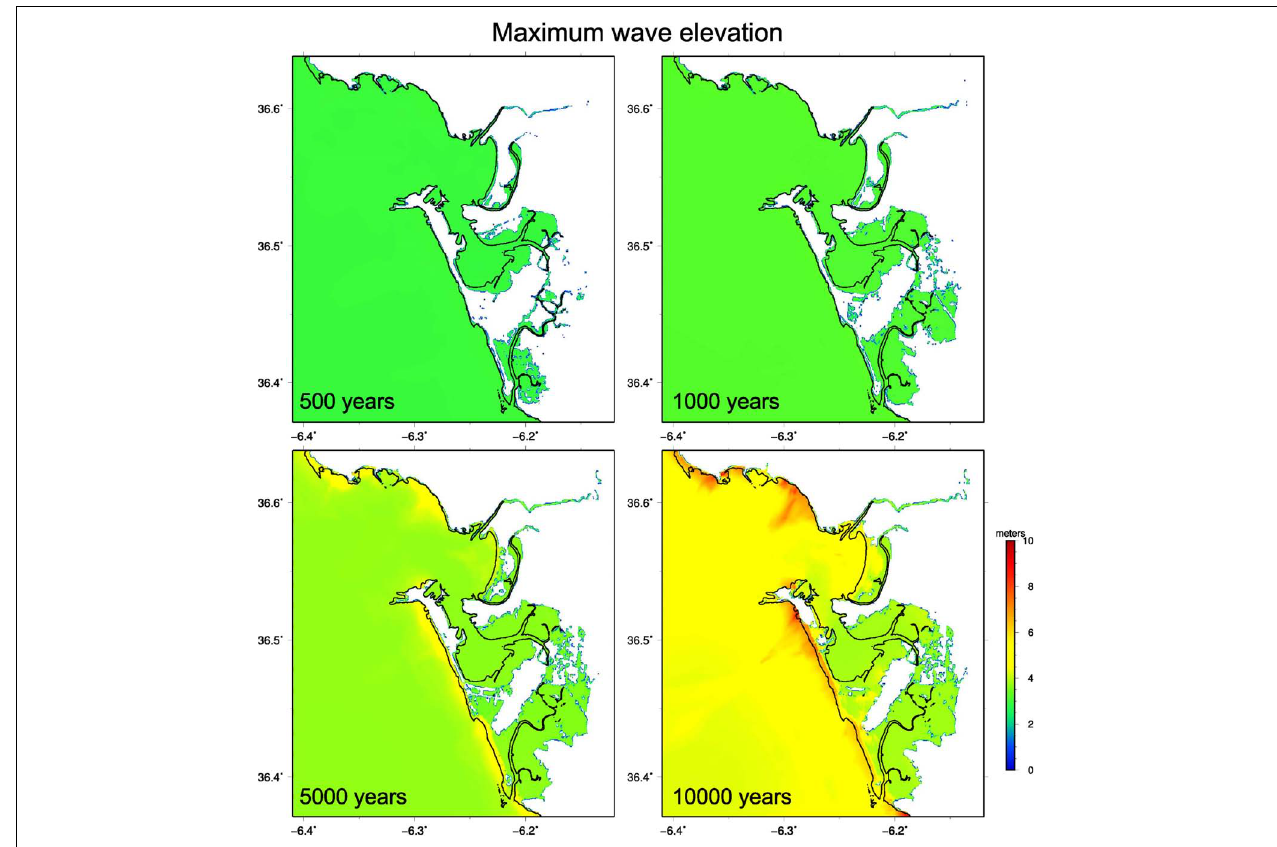
FIGURE 10 | Maximum wave elevation for different return periods. 99% confidence